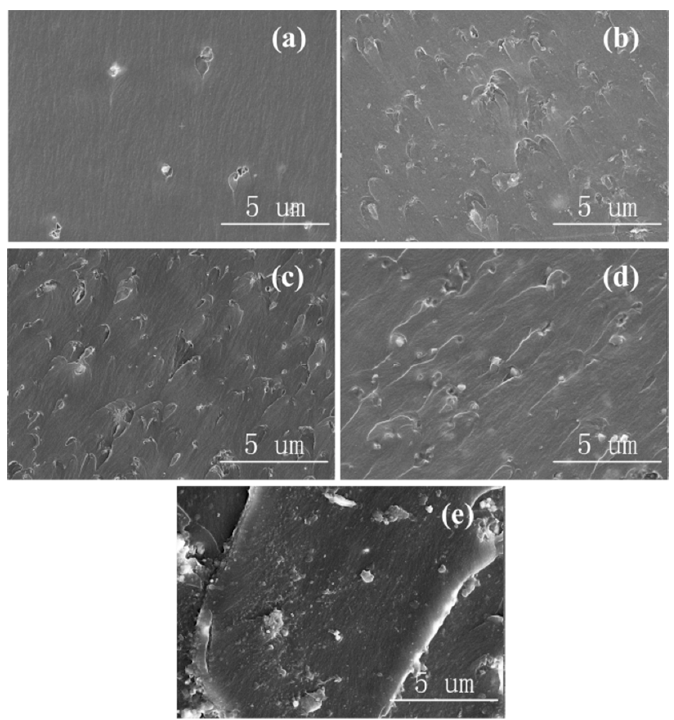
Figure 4. SEM images of Al 2 O 3 -NPLs / epoxy resin composites with ( a ) 1 wt.%, ( b ) 3 wt.%, ( c ) 5 wt.%, ( d ) 7 wt.%, and ( e ) 10 wt.% of Al 2 O 3 filler.